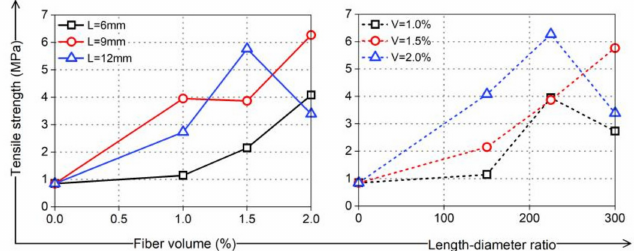
Figure 18. Tensile strength of PVA-reinforced coral cement-based